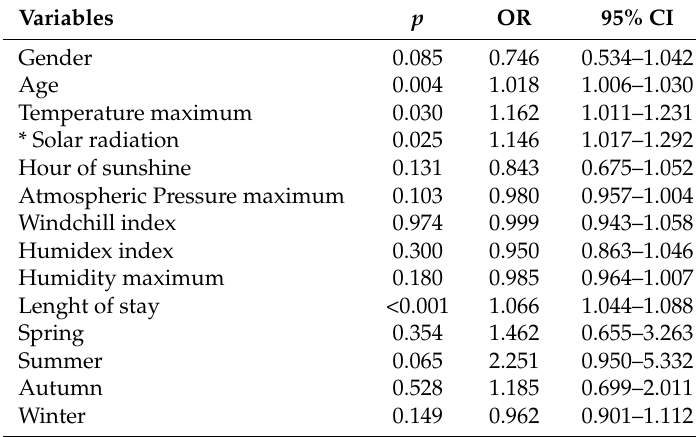
Table 3. Relationship between potential explanatory variables and admission of bipolar patients in an emergency psychiatric ward: results from logistic regression